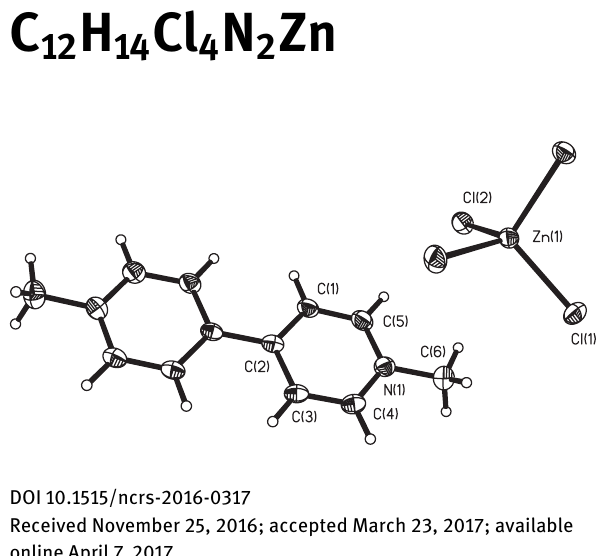
Table 2: Fractional atomic coordinates and isotropic or equivalent isotropic displacement parameters (Å 2